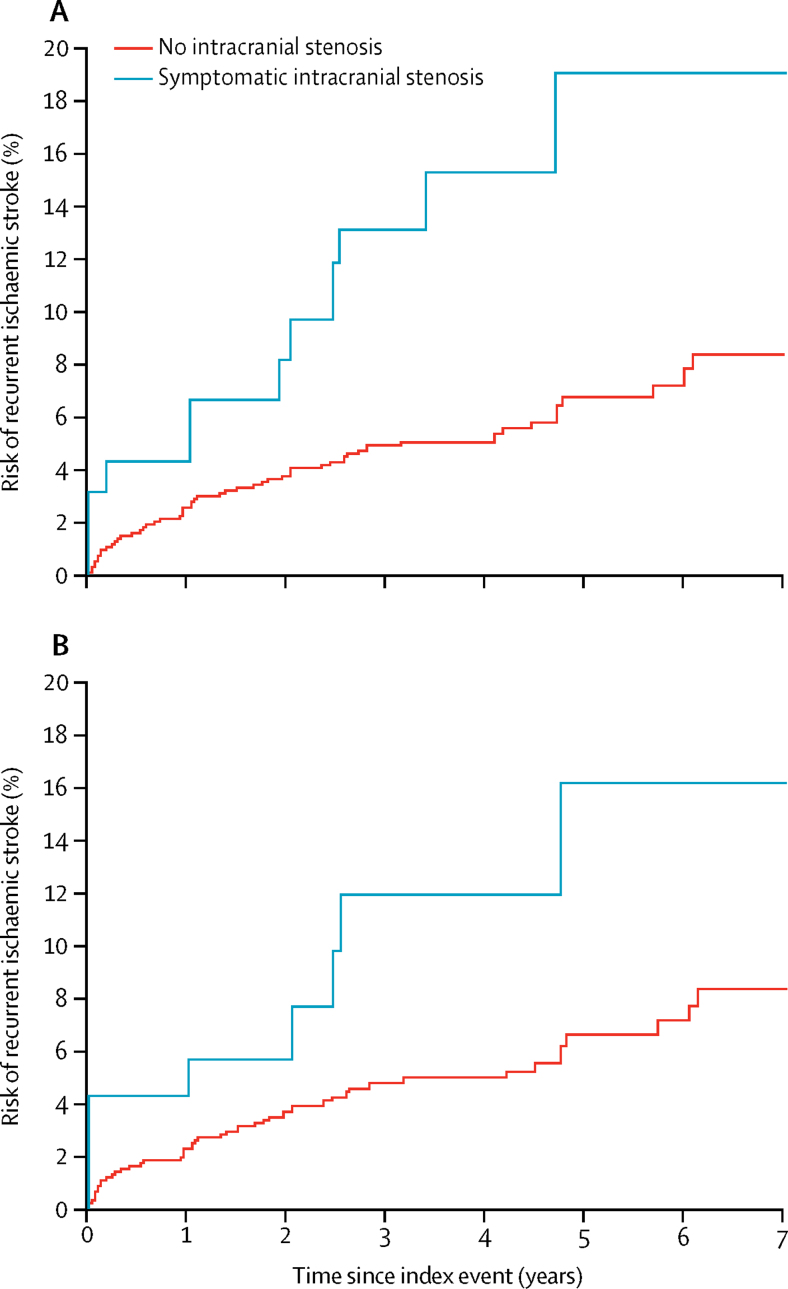
Risk of recurrent ischaemic stroke in patients with 50–99% symptomatic intracranial stenosis and those without intracranial stenosisGraphs show the 7-year risk of recurrent ischaemic stroke in all patients (A) and excluding those with atrial fibrillation or cardioembolic cause (B).